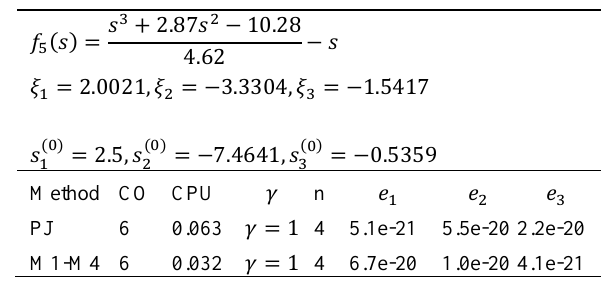
Comparison of single roots finding methods 3 +2.87𝑠 2 −10.28 (𝑠) = 𝑠 𝑓 − 𝑠 , 𝑠 = 2.5 , 𝛼 = 2 ,CO=4 5 0 4.62 Method